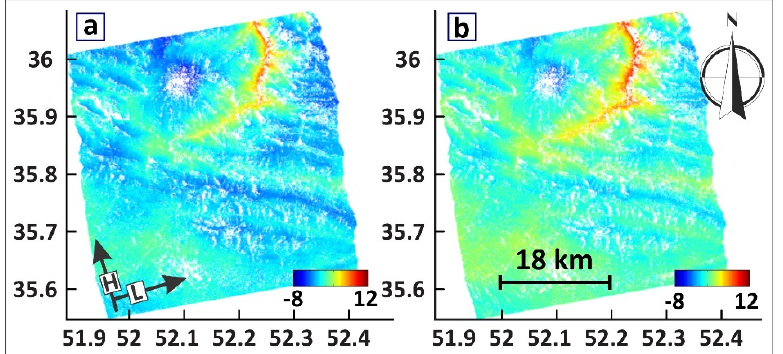
Figure 2. Comparison of unwrapped interferograms for ALOS interferometric pairs of 24 July 2007 and 13 June 2009 produced by ( a ) StaMPS and ( b ) our modified unwrapping method. The perpendicular baseline is 1290